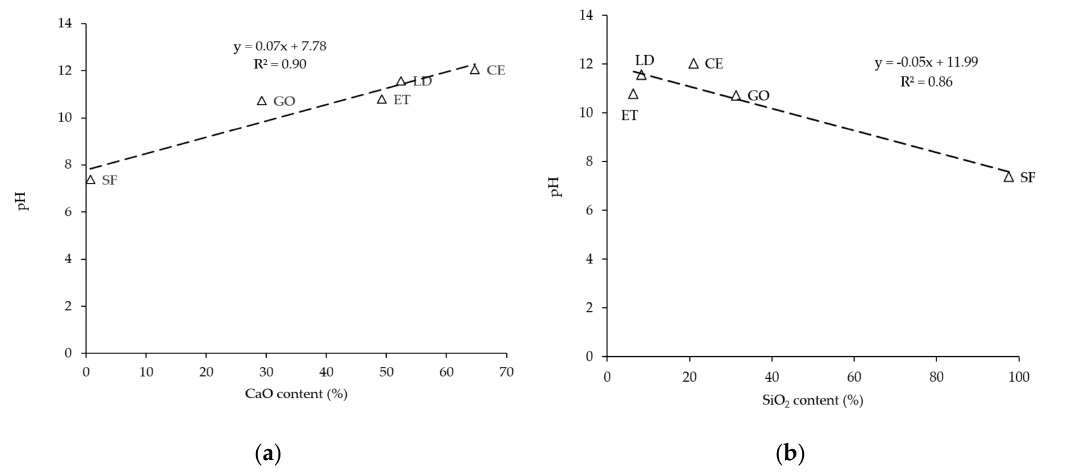
Figure 6. Correlation of pH of bitumen emulsion with: ( a ) CaO content %; ( b ) SiO 2 content